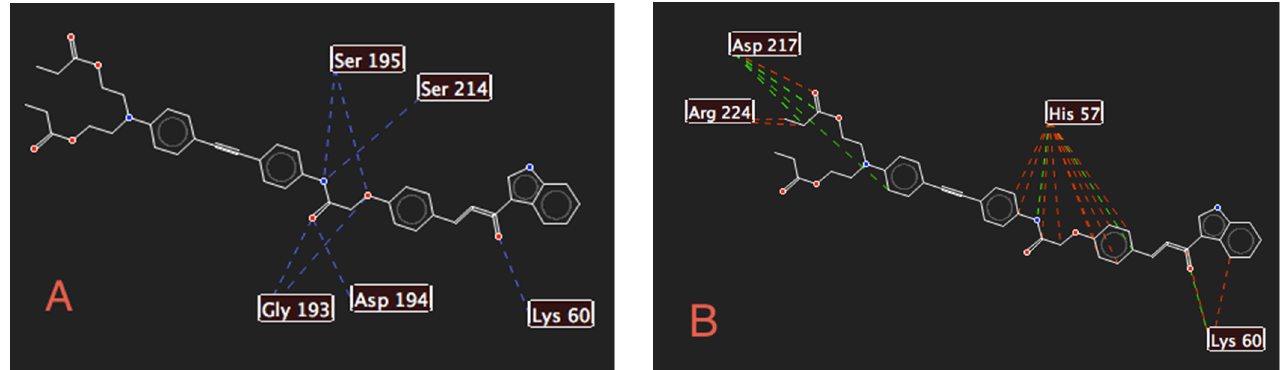
Molecules 2021 , 26 , x FOR PEER REVIEW 10 of 15 Figure 9. ( A ) Hydrogen bond and ( B ) electrostatic interactions between 15 and KLK5 protease.